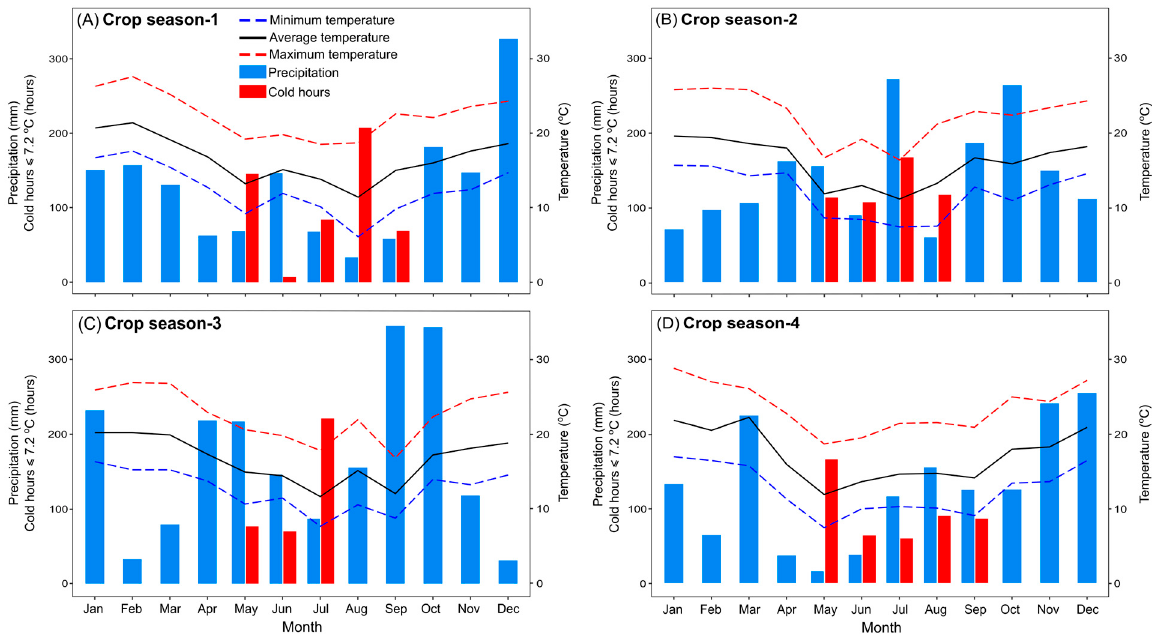
Figure 1. Minimum, average and maximum temperatures ( ◦ C), number of chilling hours ≤ 7.2 ◦ C, and monthly accumulated precipitation (mm) during the growing seasons 1 ( A ), 2 ( B ), 3 ( C ) and 4 ( D ).